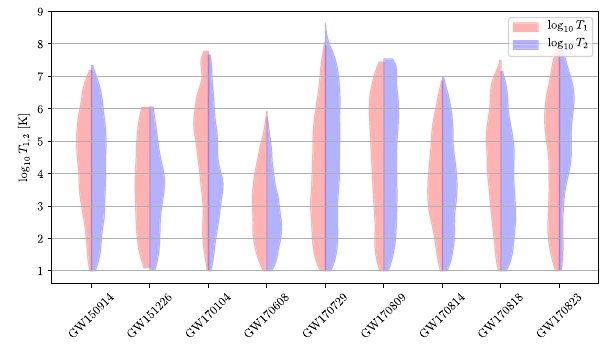
Fig. 2 Split violin plots which show the marginalized posteriors of log 10 T 1 (left in red) and log 10 T 2 (right in violet) of the parental black holes of each of the O1 and O2 (first and second observing run of the Advanced LIGO and Virgo) binary black-hole event (GW151012 is excluded from our analysis because it is not a confident detection). All posteriors exclude the possibility of T 1 and T 2 > 10 9 K. Within the credible regions, the posteriors show no particularly strong support at any specific values of T 1 and T 2 , suggesting that we have no found any evidence of intrinsic radiation of the source binary black holes of O1 and O2